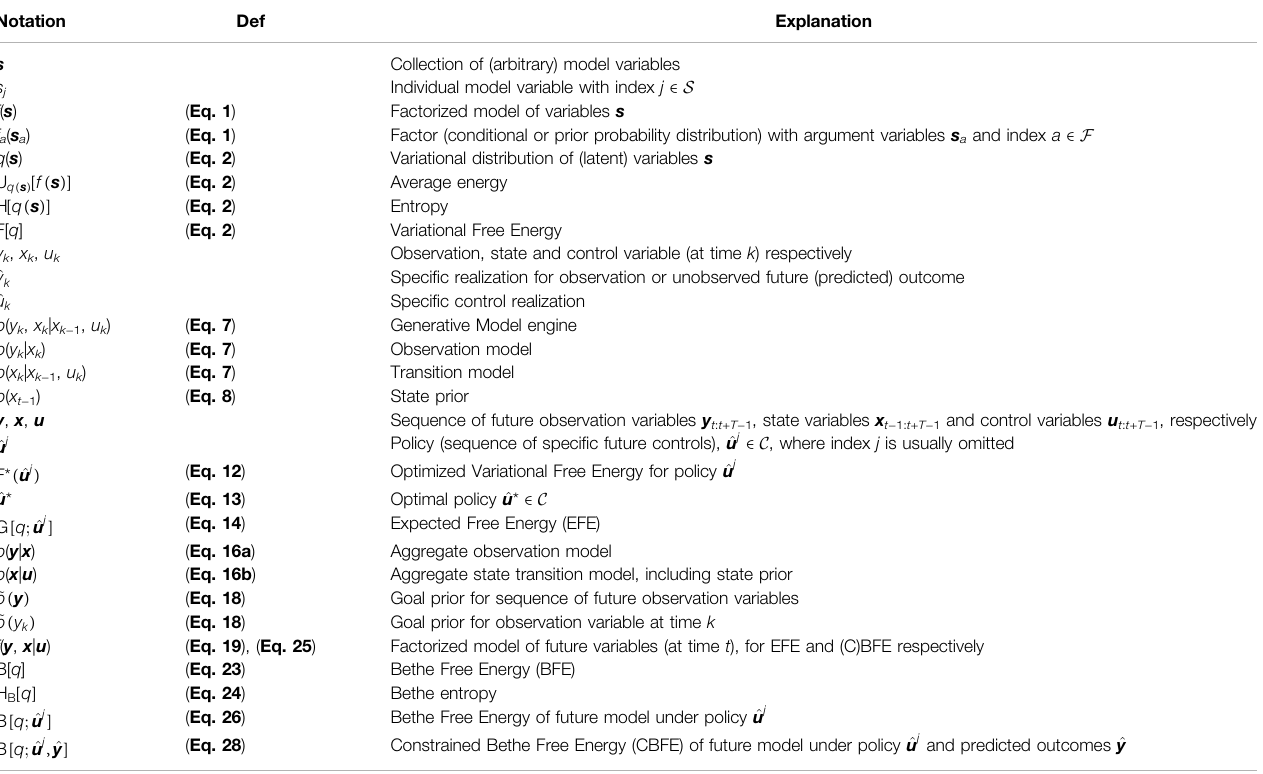
TABLE 1 | Summary of notational conventions throughout the